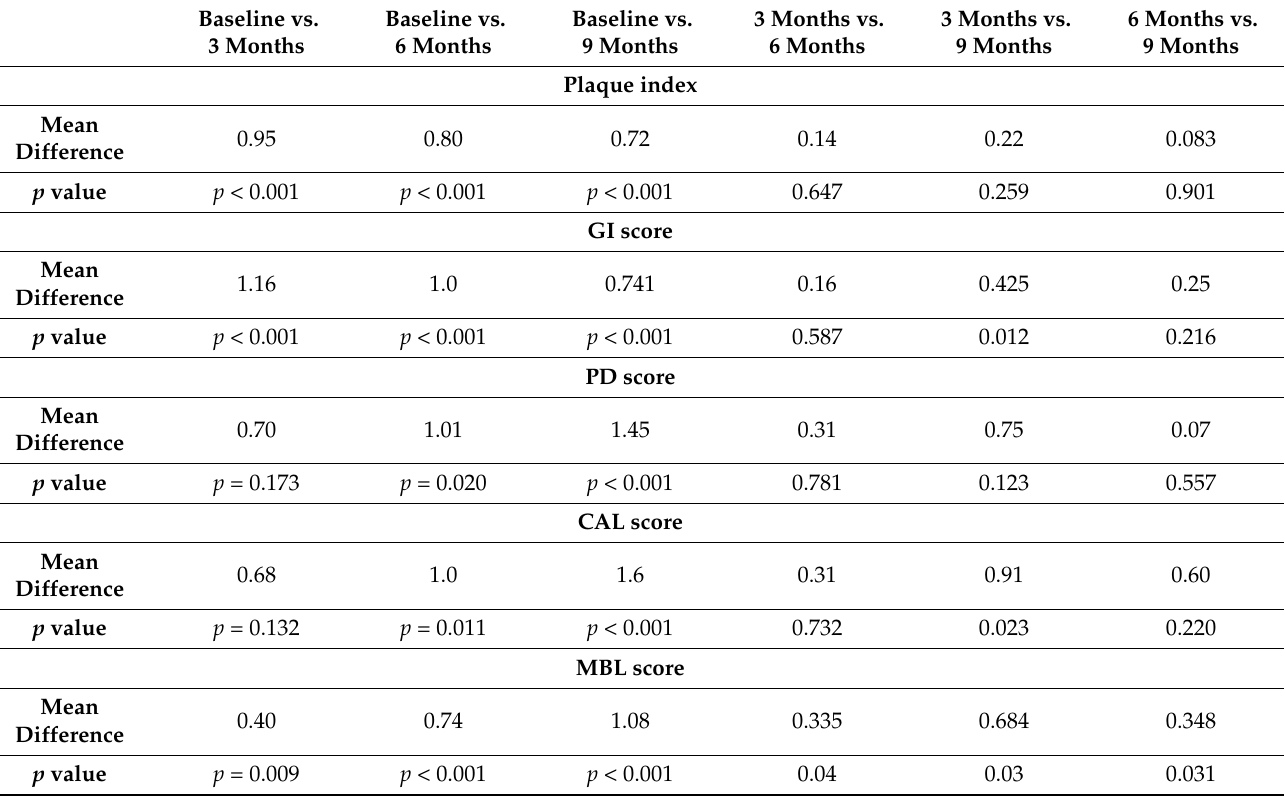
Table 4. Results of repeated-measures ANOVA, followed by Bonferroni’s post hoc test